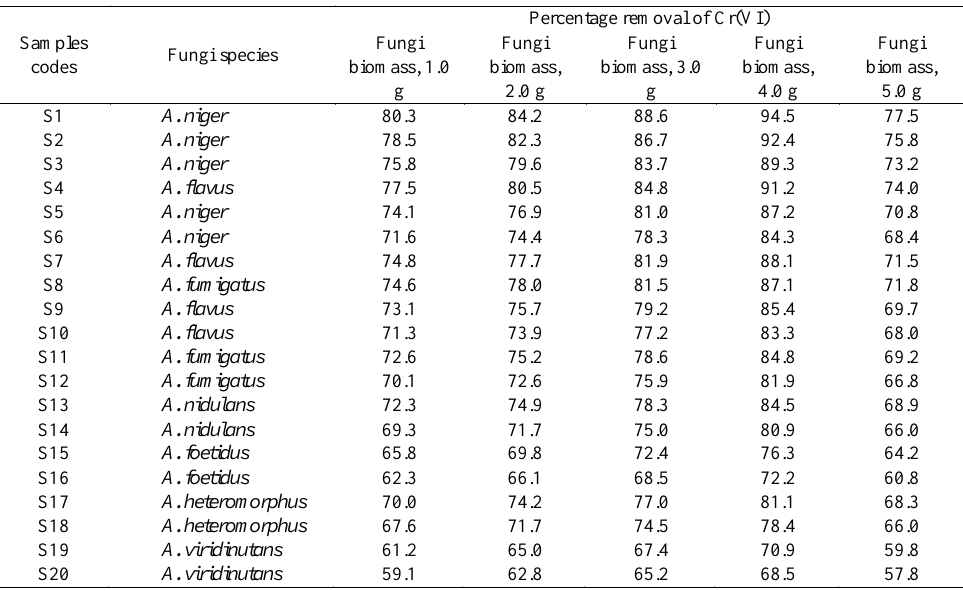
Table 5: Effect of fungus biomass on removal percentage of Cr(VI) in a tannery industry wastewater by isolated fungi from tannery industry wastewater contaminated soil against an optimum pH of 3,